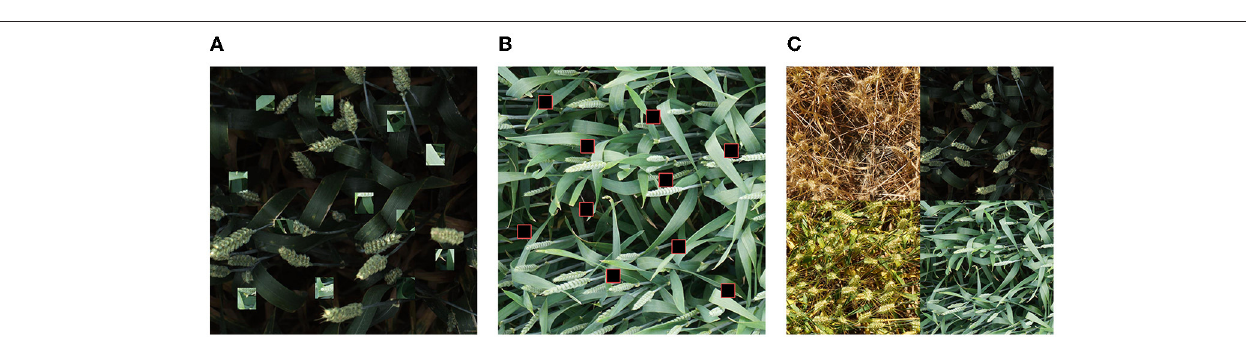
FIGURE 4 | Illustrations of three data enhancement methods: (A) CutMix method; (B) Cutout method; (C) Mosaic